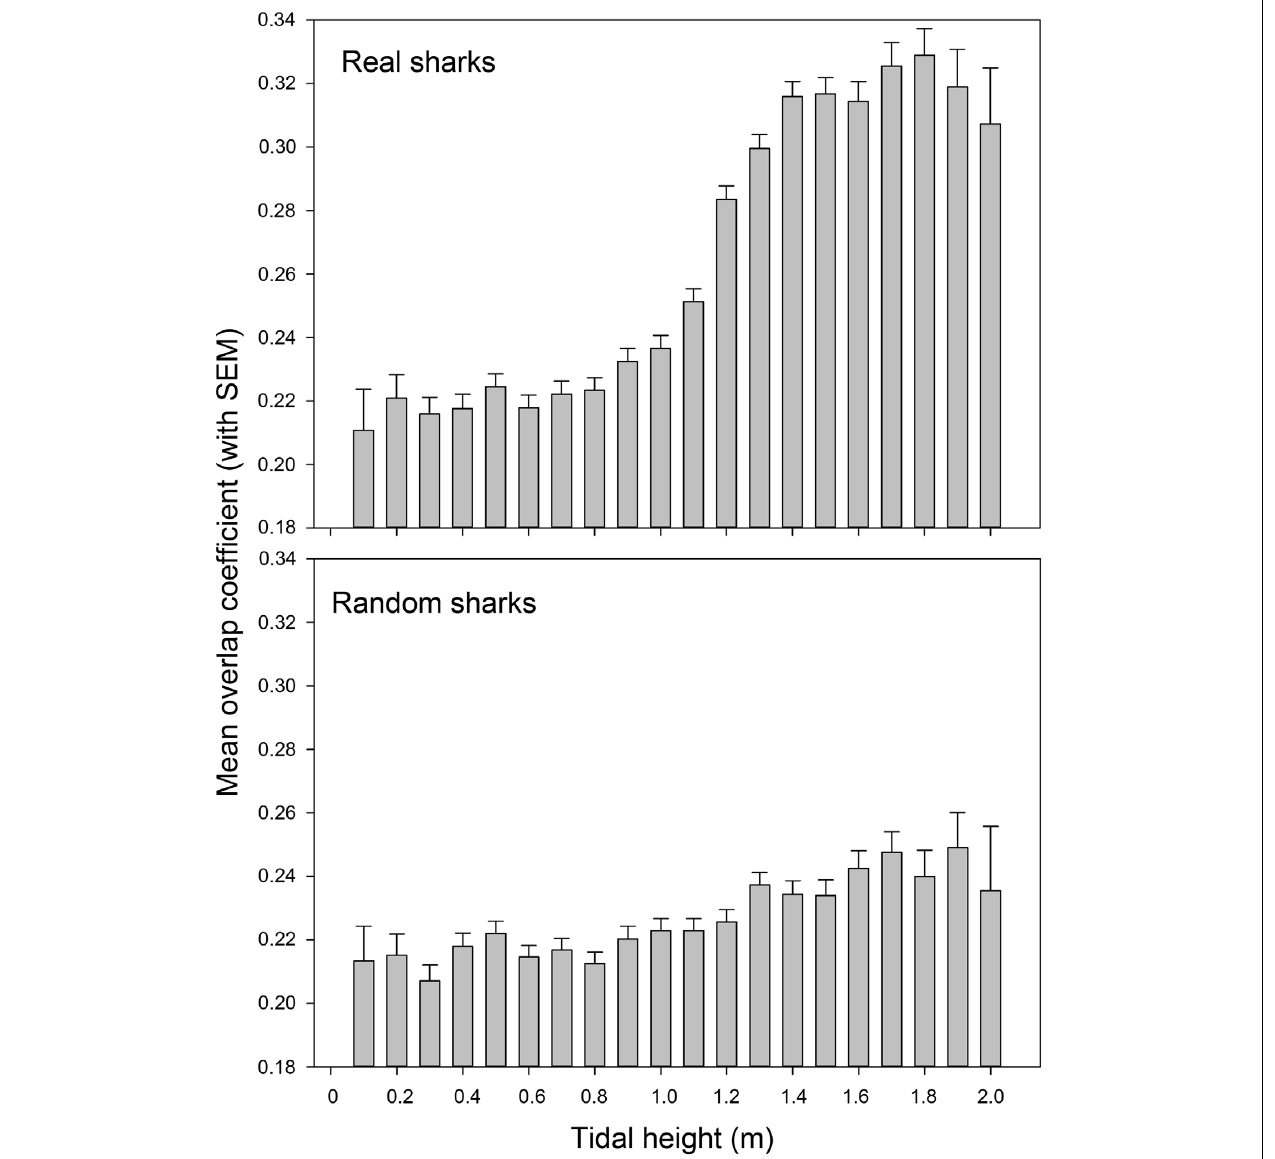
FIGURE 7 | Mean overlap coefficient between blacktip reef sharks Carcharhinus melanopterus and sicklefin lemon sharks Negaprion acutidens over the course of the tidal cycle for both real and random